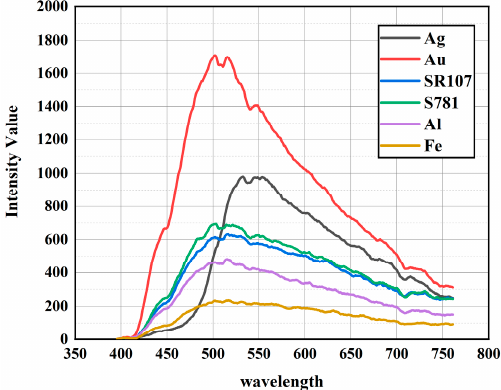
Figure 11. Spectral characteristic curve of space debris material.